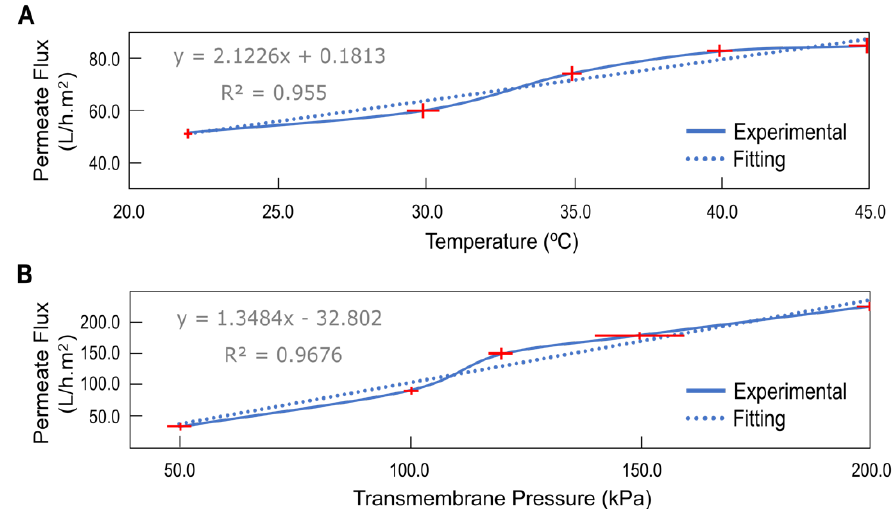
Figure 3. Effect of ( A ) temperature and ( B ) transmembrane pressure on permeate flux at pH 6.0 ([NH 4+ ], [NO 3 − ], [PO 43 − ] = 100.0 mg/L).